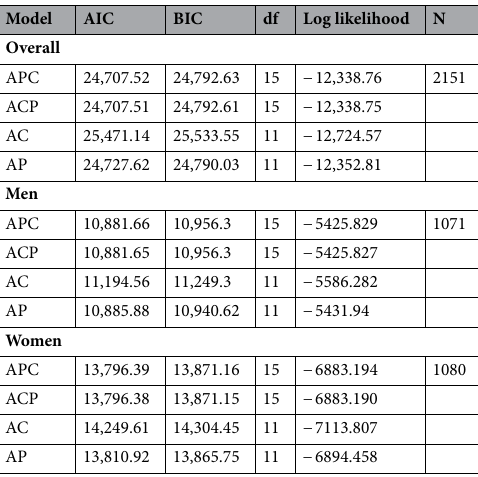
Table 1. Goodness of fit of APC for chewing difficulty among Korean adults from 2007 to 2016–2018. AIC: Akaike information criterion; BIC: Bayesian information criterion (BIC); d.f.: degree of freedom; APC: age- specific rates for a particular period (2007), after adjustment for cohort effect model; ACP: age-specific rates for a particular cohort (1951), after adjustment for period effect model; AC: age/cohort model; AP: age/period model.